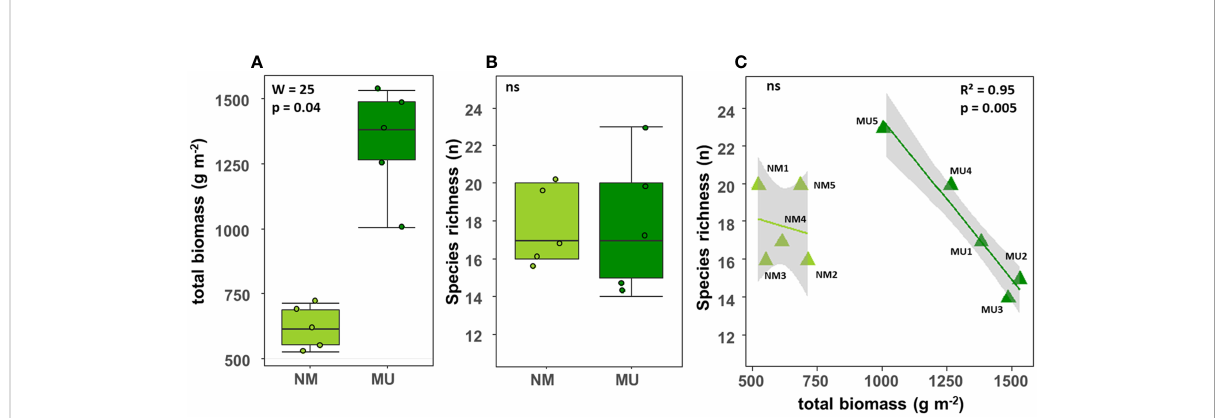
FIGURE 2 Comparison of the total biomass (A) and species richness (B) between control (NM; no mulching) and mulching-treated (MU) areas, and relationship between species richness and total biomass (C) in the 10 sampling plots. The lines in fi gure C indicate the best fi tting and its 95% con fi dence interval obtained through a generalized linear model (GLM). The boxplot indicates the median (line in the middle of the boxes), the interquartile range (boxes) and 1.5 times the interquartile range (whiskers). Results of the Wilcoxon test (A, B) or GLM model (C) are reported in each sub fi gure; the R 2 value is the pseudo-R 2 of the GLM model; ns, not signi fi cant (p >